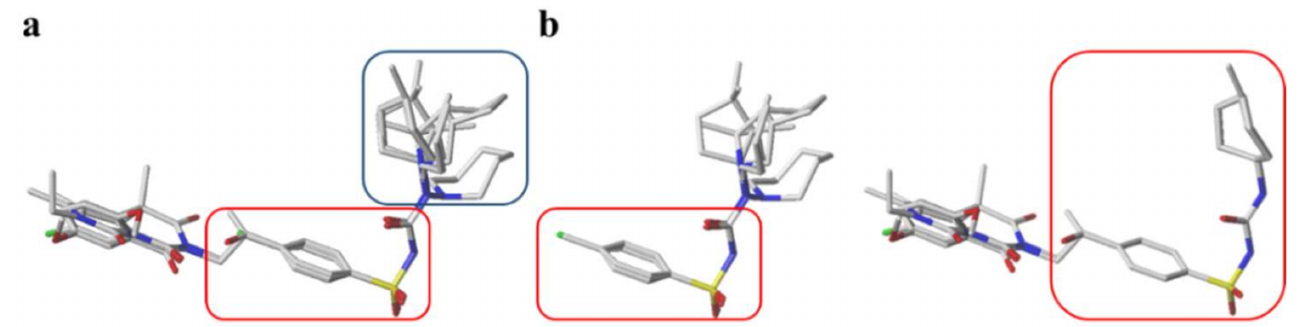
Figure 3. The alignment result of 11 sulfonylureas with the lowest energy conformations. ( a ) total align- ment result of gliquidone, glipizide, acetohexamide, glyburide, glimepiride, tolazamide, tolbutamide, chlorpropamide, gliclazide, carbutamide, and glibornuride. ( b ) grouping alignment result. The left side included tolbutamide, carbutamide, gliclazide, tolazamide, glibornuride, and chlorpropamide; The right side included glyburide, glipizide, glimepiride, gliquidone, and acetohexamide. Blue and red rectangular boxes represent the variant and the common skeleton structure of